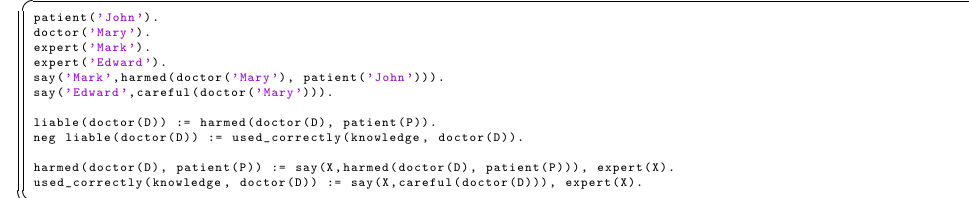
Figure 1. DL formalism.